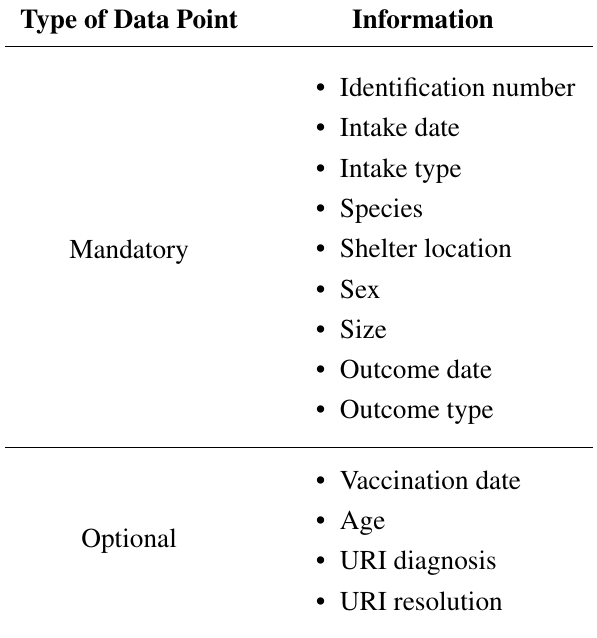
Table 2. Mandatory and optional data points as used at the study